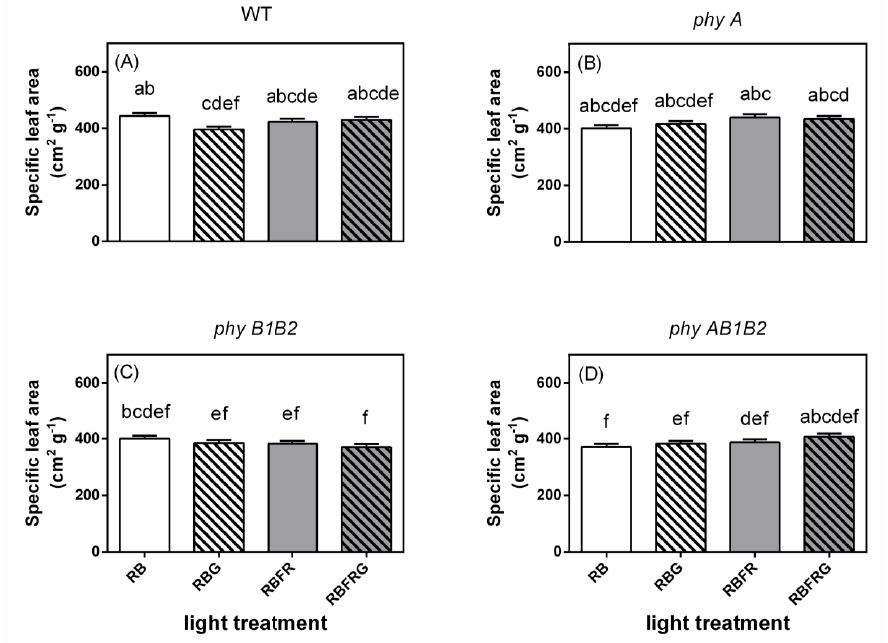
Figure A3. Effect of partial (20%) substitution of red/blue (RB; 3:1) with green (G) light in the presence or absence of far-red light (FR) on the leaf number of tomato plants 21 days after treatment. Four genotypes were studied: ( A ) WT (Moneymaker; wild-type), ( B ) phyA (phytochrome A-deficient), ( C ) phyB1B2 (phytochrome B1- and B2-deficient), and ( D ) phyAB1B2 (phytochrome A-, B1-, and B2-deficient). Light treatment and genotype did not significantly interact ( p = 0.629). Data presented are averages, with the SE based on 5 blocks ( n = 5), each containing 3 replicate plants (Exp1).